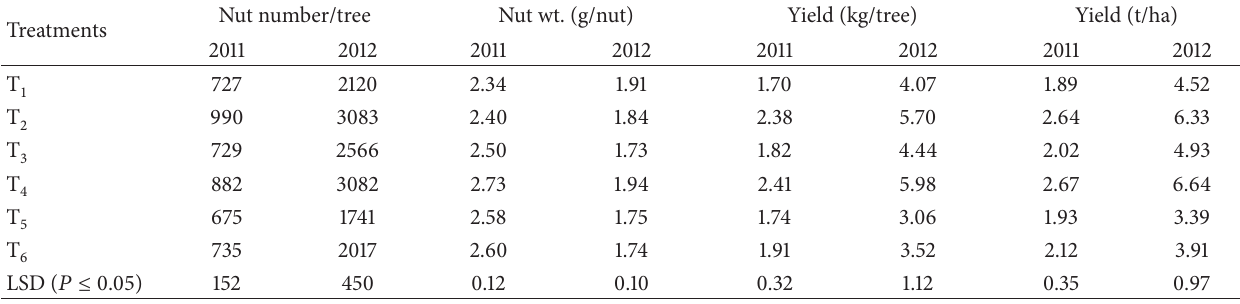
Table 3: Effect of N&K fertigation on nut number and yield of almond.